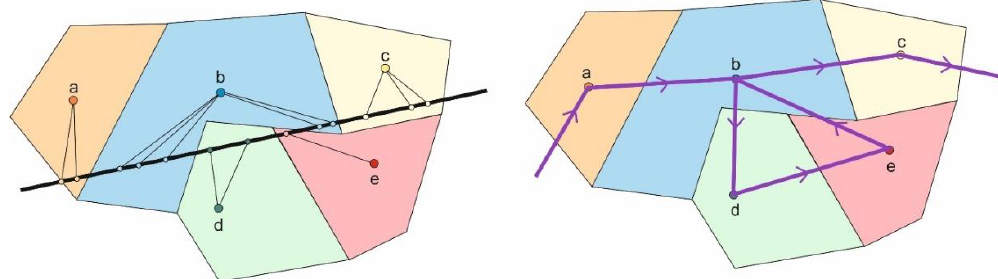
Figure 4. Common points of original trajectory (small circles) of a trajectory (black line) and centers (larger circles) in assigned colors ( left ), CP trajectory after step B as sequence of cluster centers a-b-d-e-b-c in purple ( right ).